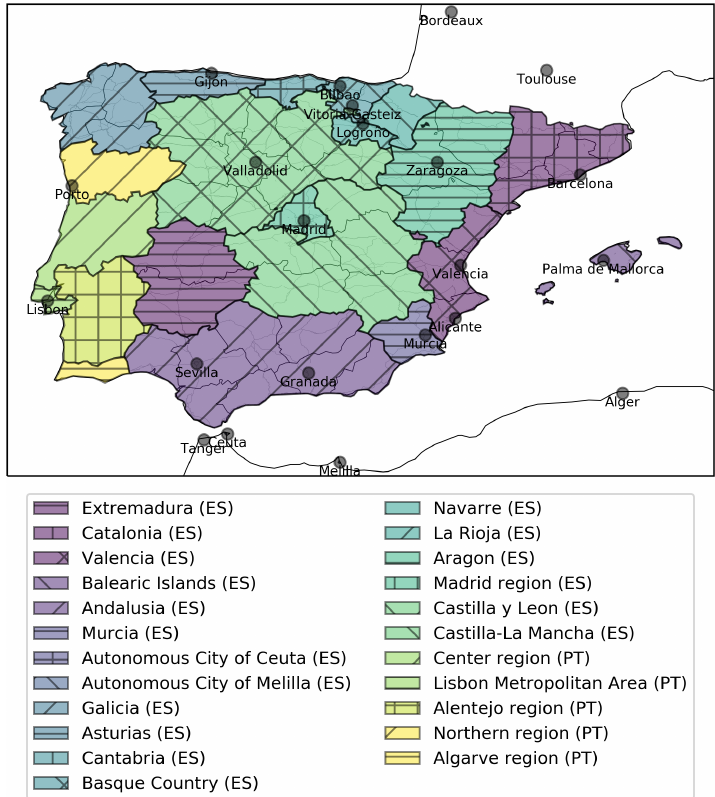
Figure G1. Administrative regions of the Iberian Peninsula and main cities over the domain of study.